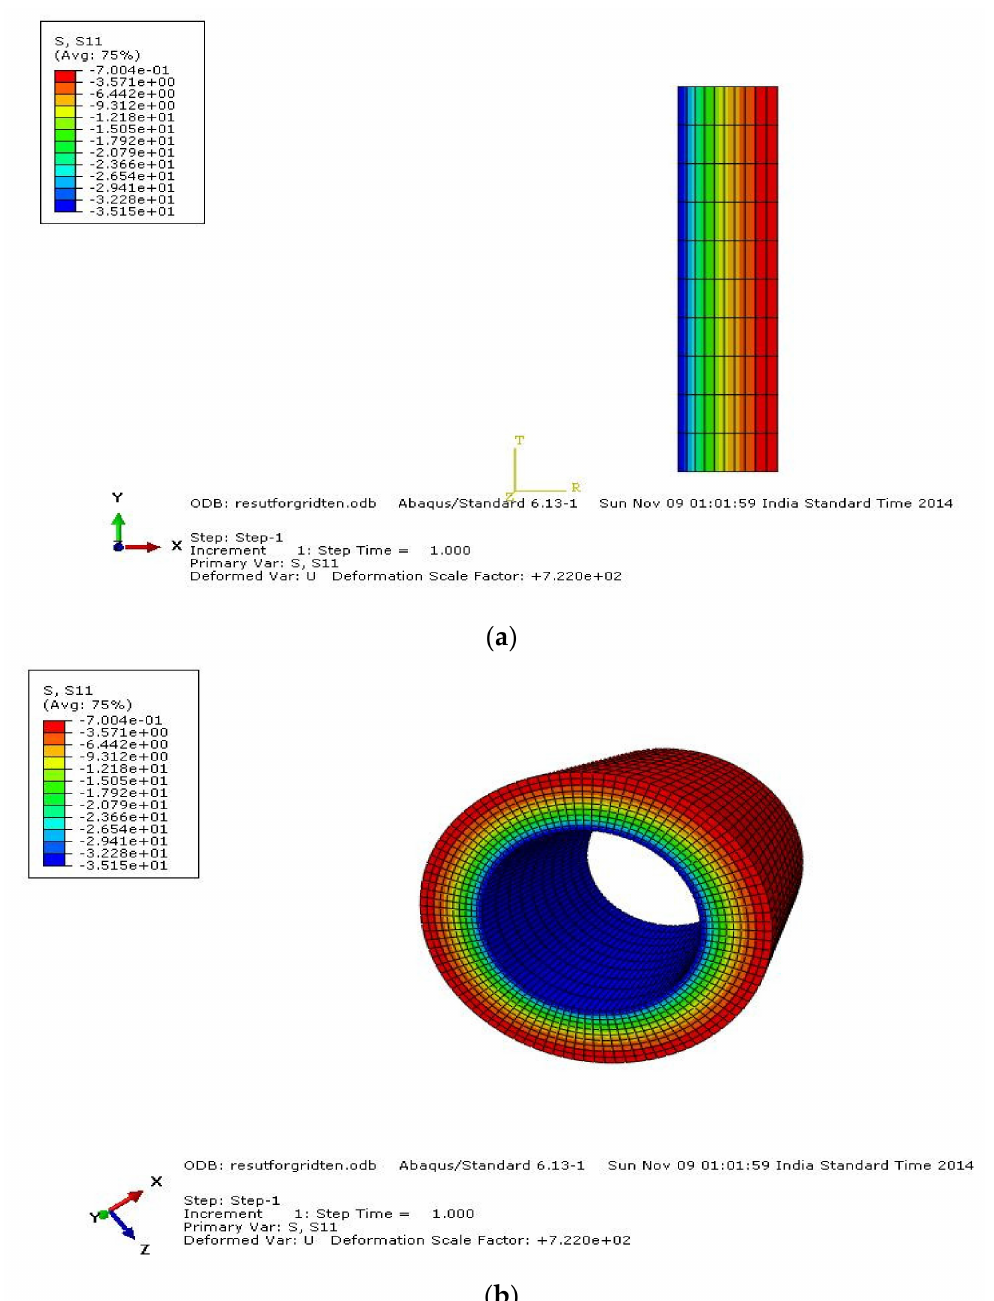
Figure 5. Analysis on sweep of radial stress elements: ( a ) before, ( b )